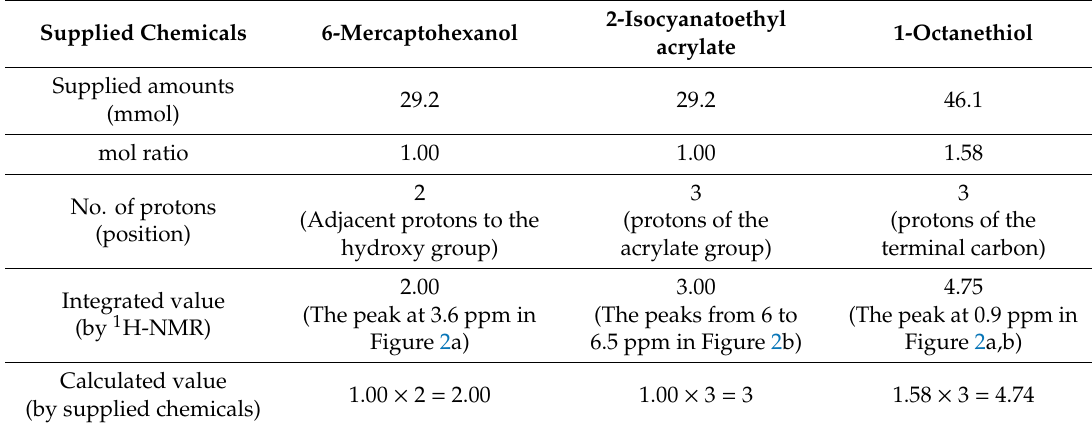
Table 1. The ratio of protons of the hydroxyl and acrylate terminated ligands on quantum dots (QDs).